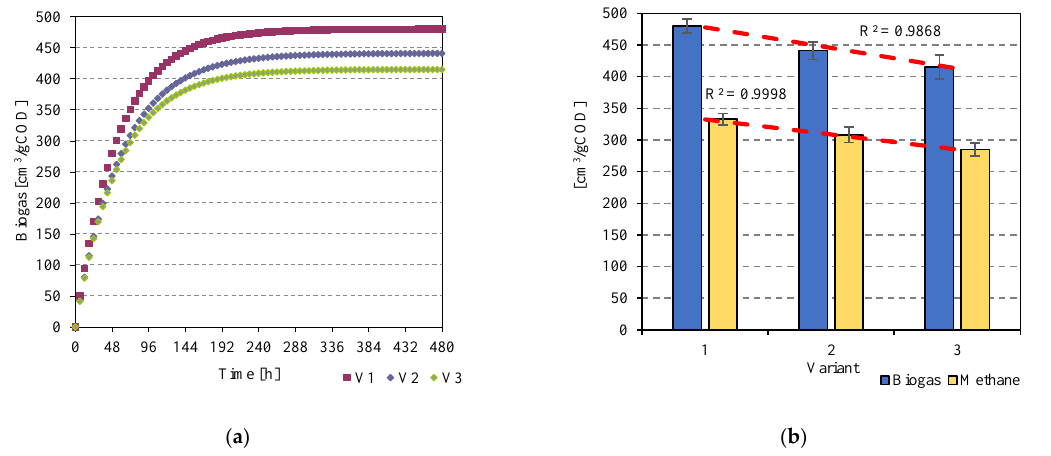
Figure 5. The course of the AD process ( a ) and correlations between OLRs applied and biogas and methane yields ( b ) achieved in S3.